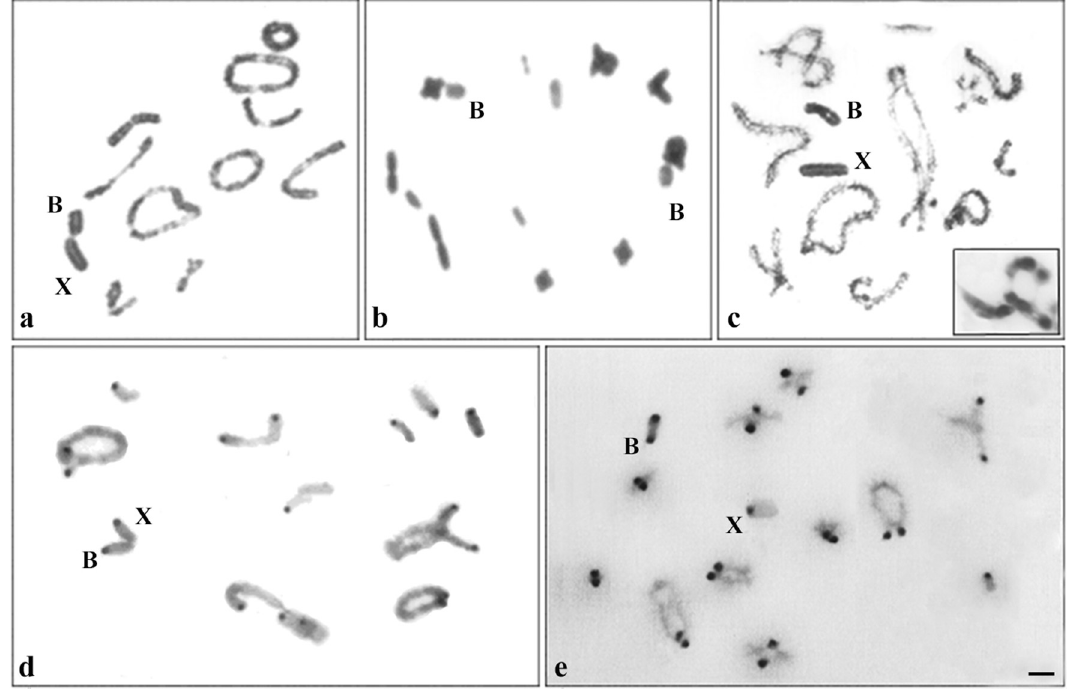
Figure2 -Meioticcellsofthespecies Rhammatocerusbrasiliensis conventionallystained(a,b,c)andC-banded(d,e).a,c,d,e)Diplotenestagewithone B chromosome. b) Diakinesis with two B chromosomes. c) Observe the variant B and the insect with three variant B chromosomes. Bar = 5 (cid:2)